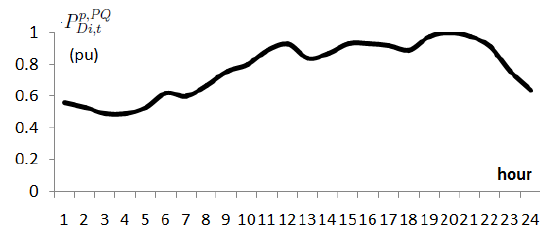
Figure 2. Base load curve: No EV connected, only constant real and reactive power (PQ) loads.